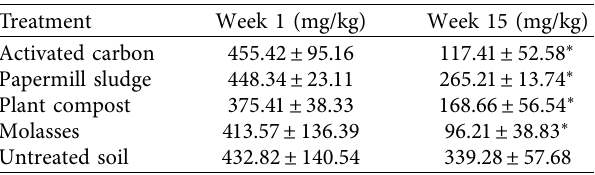
Table 4: Soil benzene concentrations as a function of amendment, weeks 1 and 15.